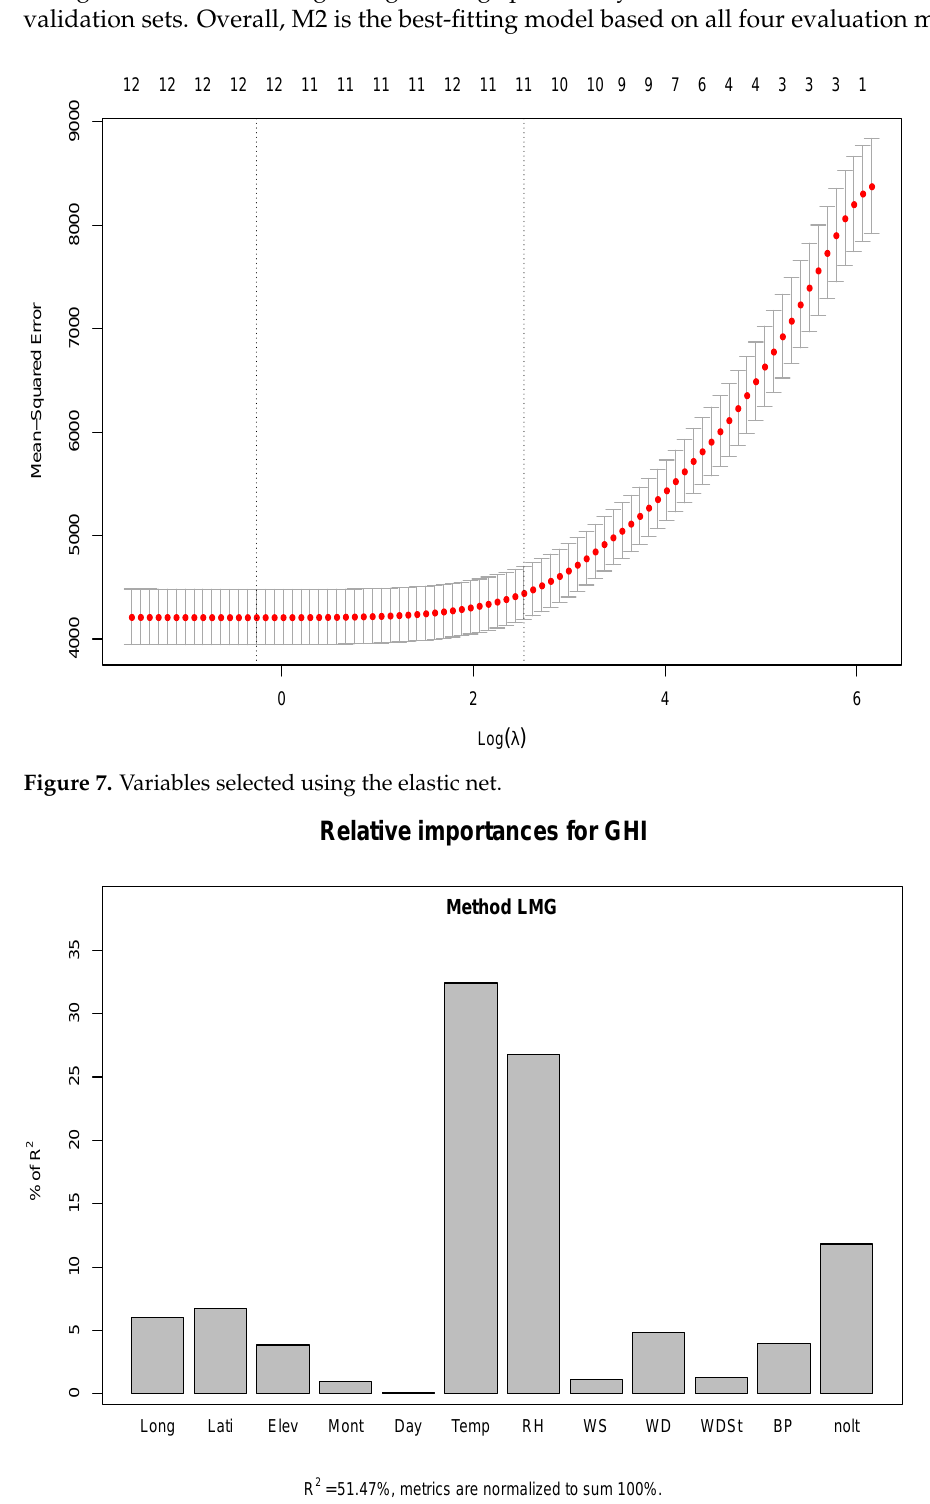
Figure 8. Relative importance for